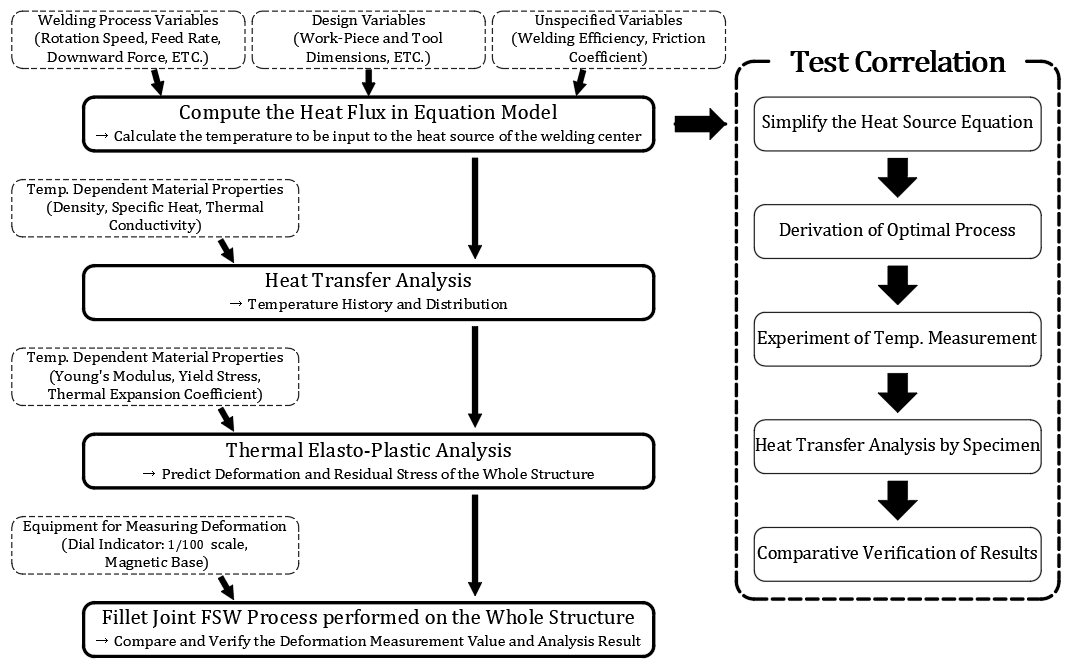
Figure 6. Flow chart of research procedure.